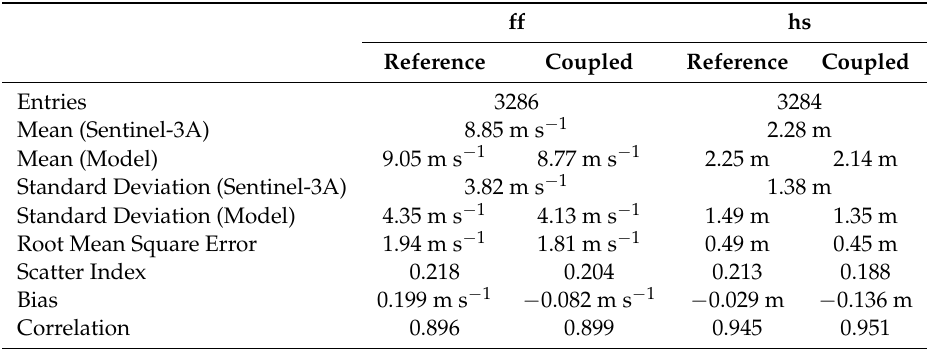
Table 1. Statistical values of the comparison between the wind speeds (ff) and significant wave heights (hs) measured by Sentinel-3A and the modelled wind speeds and significant wave heights. ff